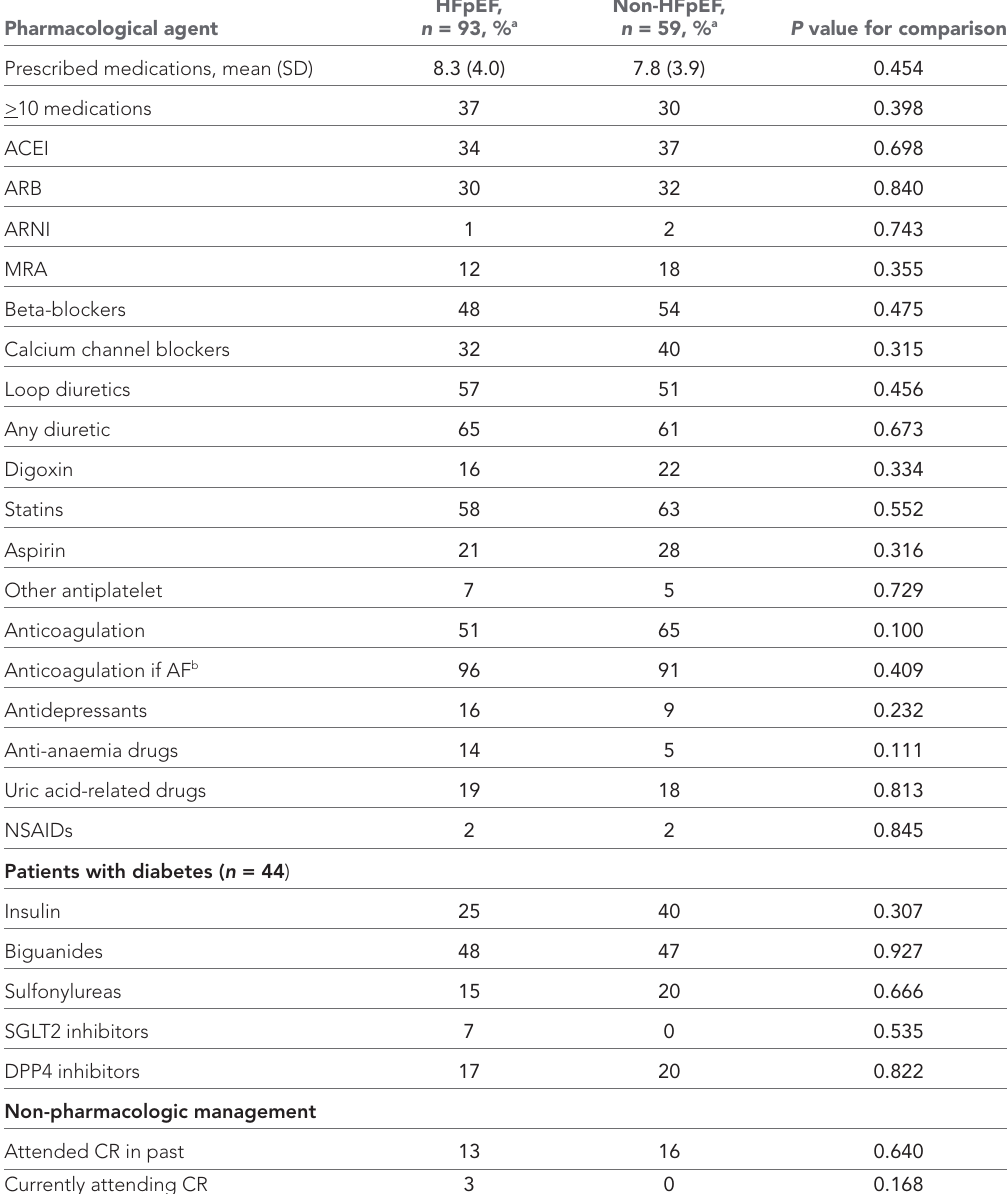
Table 4 Pharmacological treatment by HFpEF diagnosis Pharmacological